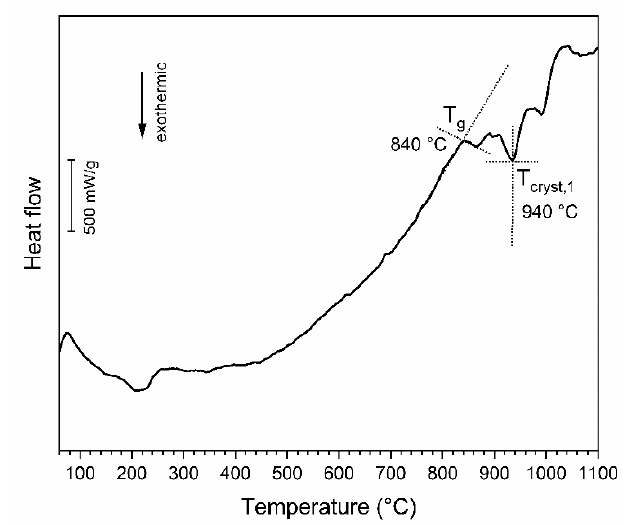
Figure 2. DSC plot for VBA powder, showing glass transition temperature (T g ) and crystallization temperature (T cryst ).